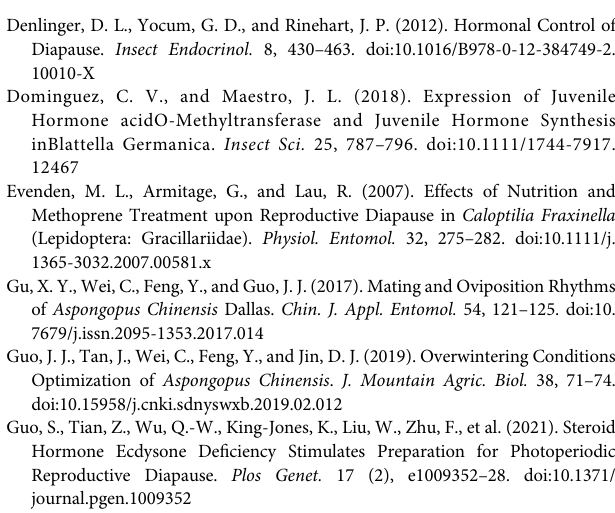
Supplementary Figure S6 | Standard curve of juvenile hormone.